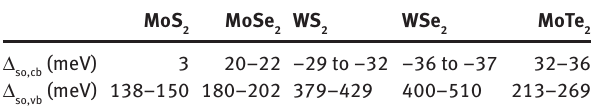
Table 1: Amplitude of the spin-splitting at the K points of the Brillouin zone in the conduction ( Δ monolayer S-TMDs deduced from theoretical predictions and experi- mental results [8, 10, 11, 13, 20–35].